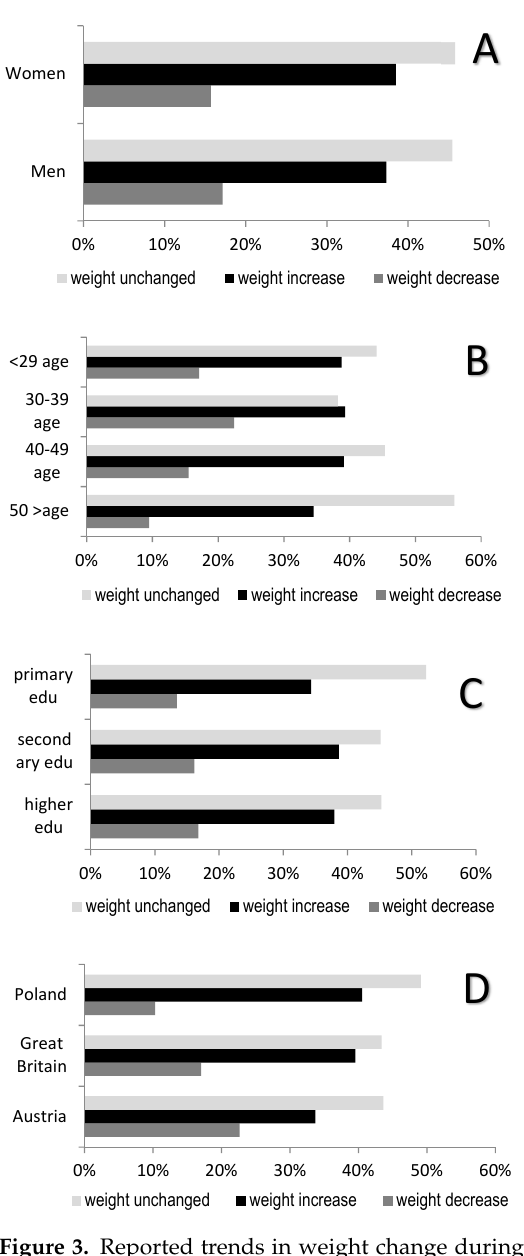
Figure 3. Reported trends in weight change during COVID-19 pandemic. Comparison between groups χ 2 Pearson’s ( A ) gender, p = 0.800; ( B ) age, p = 0.000; ( C ) education, p = 0.846; ( D ) country, p = 0.043; n = 1071.